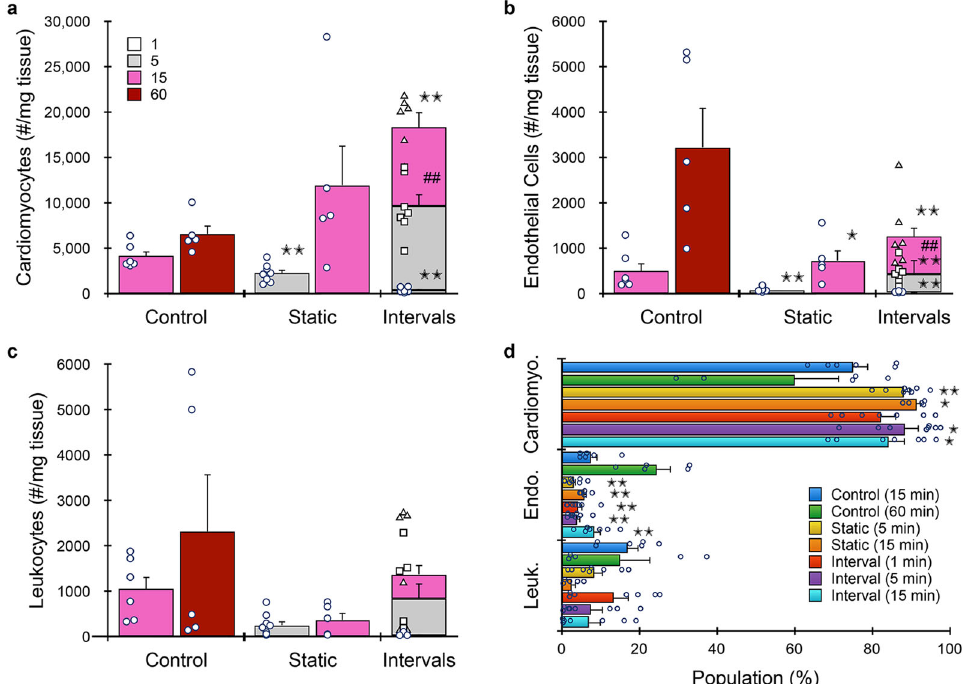
Fig. 8 Micro fl uidic platform results for murine heart. Hearts ( n = 5 to 8 independent samples) were resected, minced, processed with the micro fl uidic platform (both 50 and 15 µ m membranes), and analyzed by fl ow cytometry. We employed shorter digestion device time points due to the sensitivity of cardiomyocytes. a Micro fl uidic processing produced ~12,000 cardiomyocytes per mg after 15 min, which was ~2-fold higher than the 60 min control. Interval recovery produced optimal results again, increasing by ~50% and ~3-fold relative to the 15 min static and 60 min control conditions. b Endothelial cell and c leukocyte yields were signi fi cantly lower than the 60 min control under both static and interval formats. Interval recovery did improve results, but remained ~2-fold lower than the 60 min controls. d Population distributions obtained for each processing condition. Micro fl uidic processing generally enriched for cardiomyocytes. Data are presented as mean values ± SEM from at least three independent experiments. Circles indicate values for experimental replicates. For stacked plots, experimental replicates are indicated by circles at 15 min, squares at 30 min, and triangles at 60 min. Two-sided T test was used for statistical testing. Stars indicate p < 0.05 and double stars indicate p < 0.01 relative to the 60 min control. Cross-hatches indicate p < 0.05 and double cross-hatches indicate p < 0.01 relative to the static condition at the same digestion time. p values for all comparisons are presented in the Source Data fi